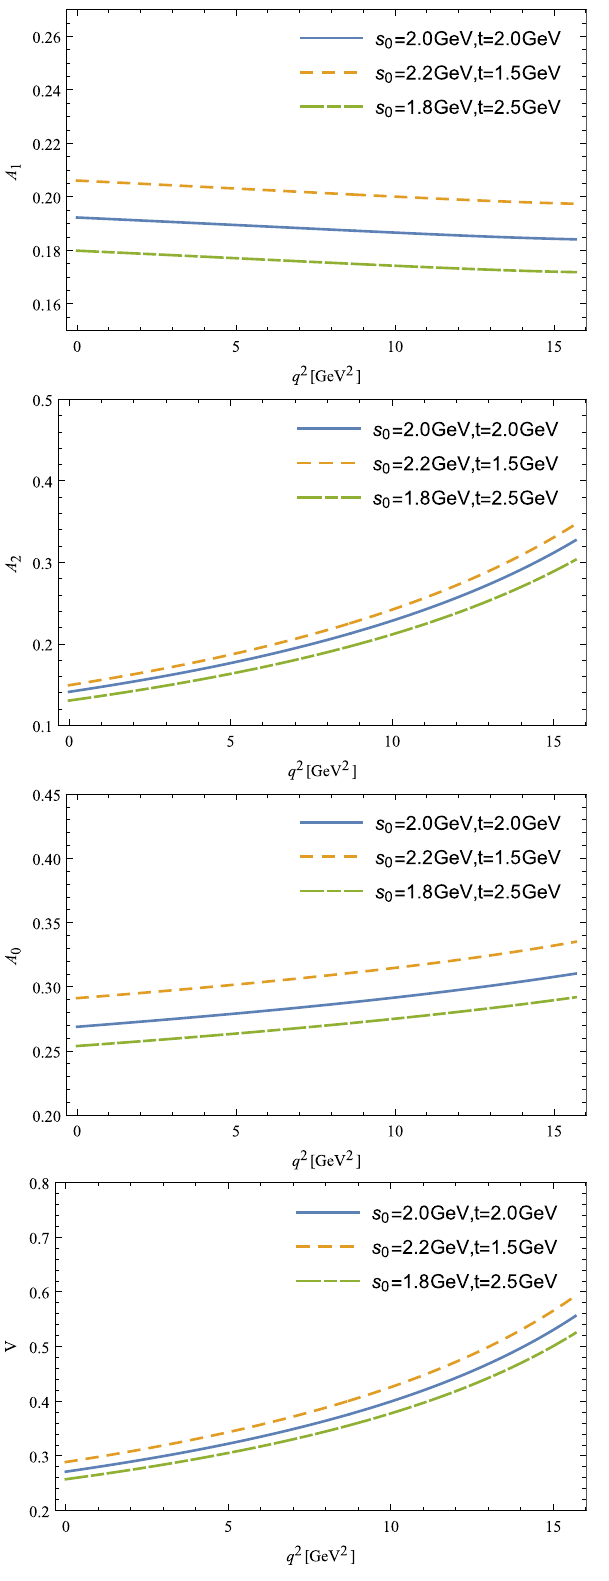
Fig. 4 B → a 2 ( 1320 ) form factors as functions of q